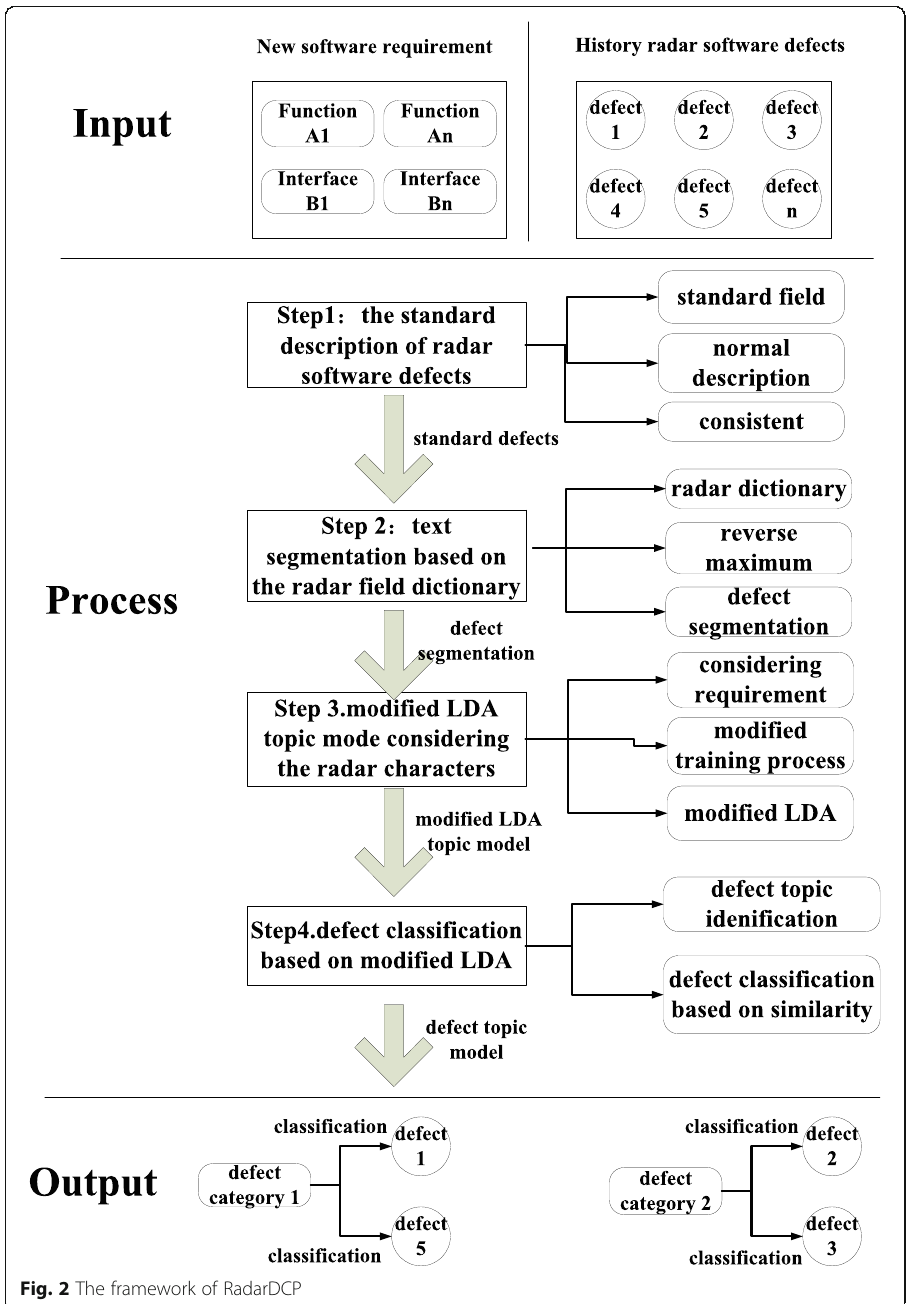
Fig. 2 The framework of Process: Step 1: Standardized preprocessing of radar software defect data Based on the mechanism of software defect generation and propagation, a standard- ized software defect data record structure is developed, including related functions, de- fect cause, defect description, defect impact, impact level, control measures, and the other fields. At the same time, for each field content description, grammatical structure,